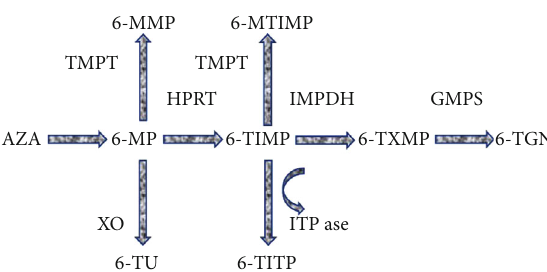
Figure 1: Azathioprine metabolism. AZA: azathioprine;